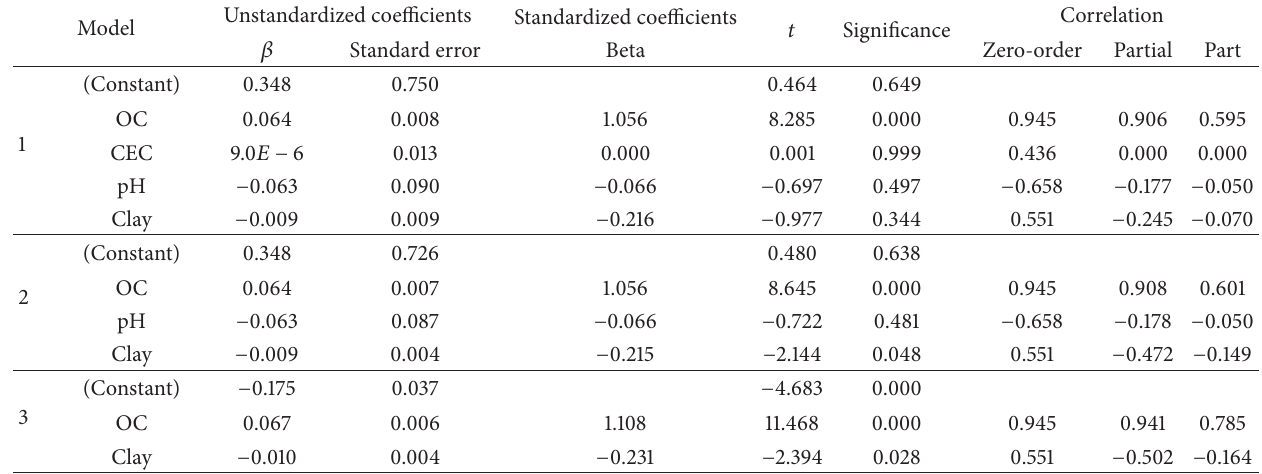
Table 6: Regression coefficients of models when each soil factor removed a .